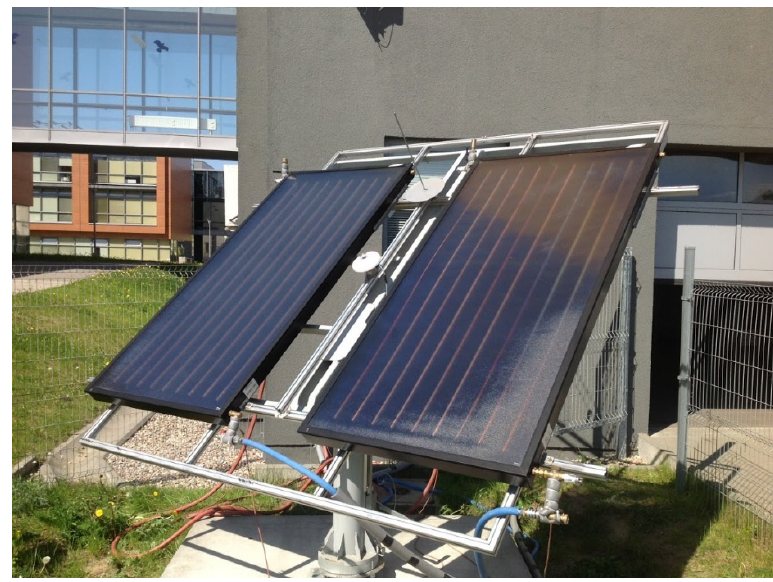
Figure 2. Outdoor platform with solar flat-plate